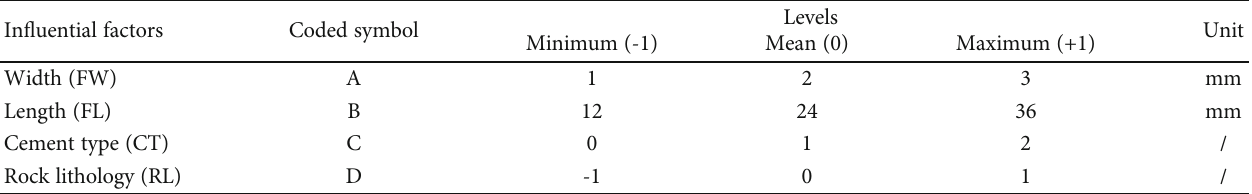
Table 1: The considered factors in fl uencing frost heaving force and their levels for the RSM model. In fl uential factors Coded